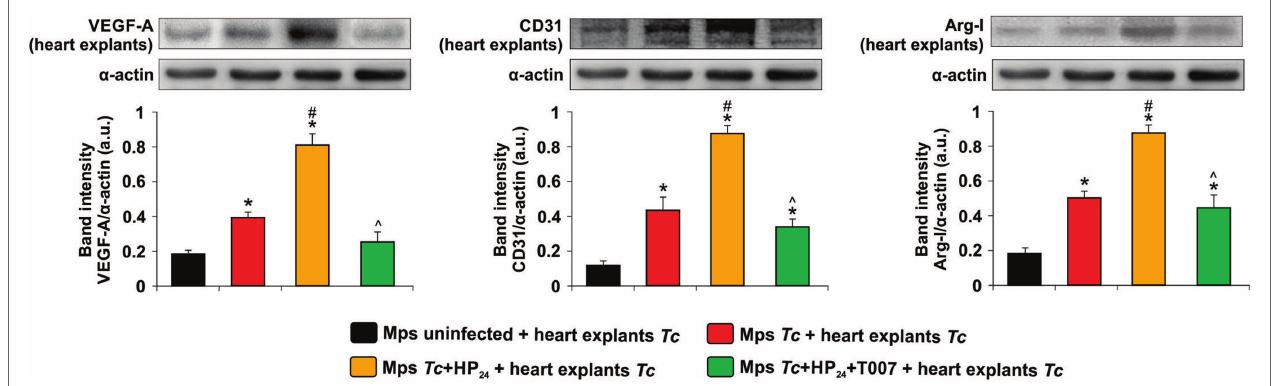
FigUre 5 | Effect of Trypanosoma cruzi -infected macrophages from untreated or HP 24 -treated mice on the expression of proangiogenic proteins in T. cruzi -infected heart explants. Peritoneal macrophages were obtained from uninfected and T. cruzi -infected mice at 10 dpi. Macrophages were either pretreated or not with T0070907 and then treated with HP 24 . Then, the cells were cocultured with heart explants (100 mg/sample) from T. cruzi -infected mice. After 48 h, heart explants were collected and homogenized. Vascular endothelial growth factor A (VEGF-A), CD31, and Arginase I (Arg-I) expressions were determined by Western blot with specific antibodies. Protein levels were normalized against α -actin. Results represent the mean band intensity ± SEM of three independent experiments (five mice per group). * P < 0.05 vs. macrophages from uninfected mice + heart explants from T. cruzi -infected mice, # P < 0.05 vs. macrophages from T. cruzi -infected mice + heart explants from T. cruzi -infected mice. ^ P < 0.05 vs. HP 24 -treated macrophages from T. cruzi -infected mice + heart explants from T. cruzi -infected mice. Mps, macrophages; Tc , T. cruzi